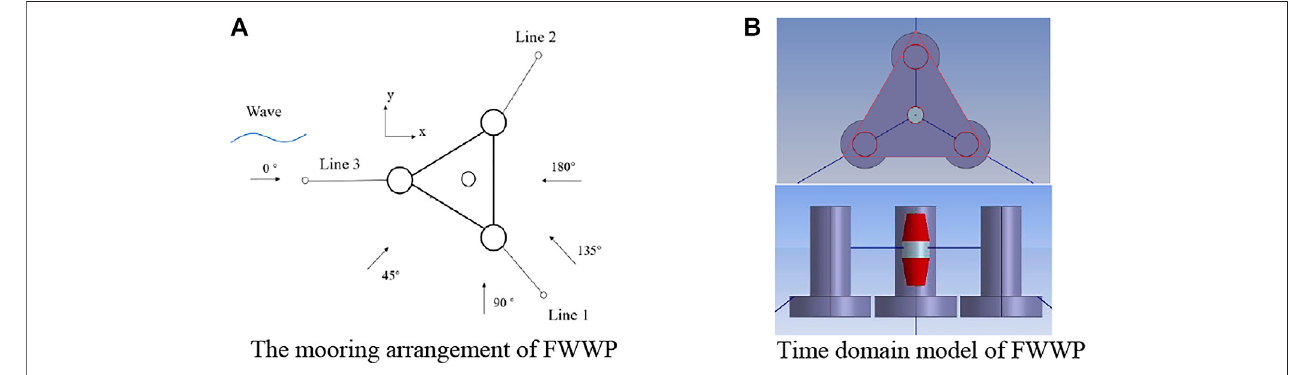
FIGURE 10 | The hydrodynamic model of the FWWP. (A) The mooring arrangement of the FWWP. (B) Time-domain model of the FWWP.